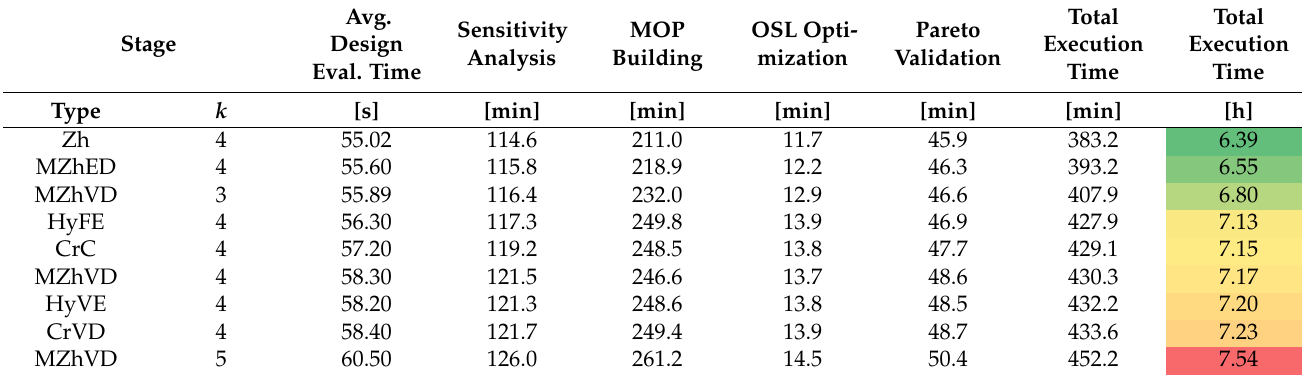
Table 8. Execution time comparison for the entire